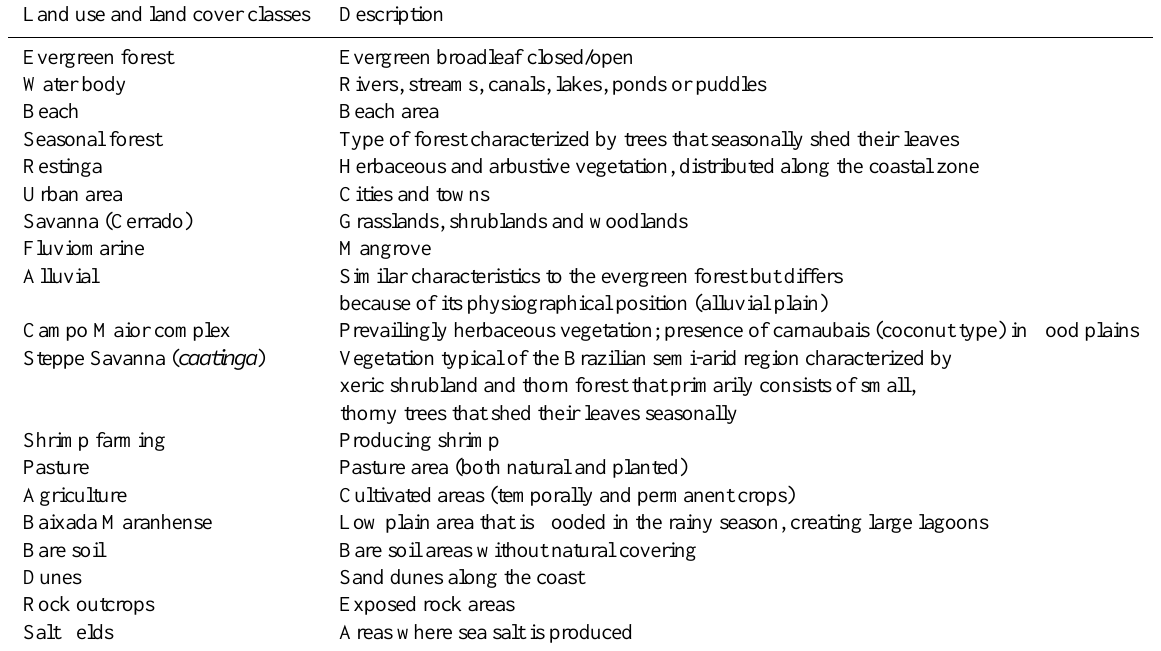
Table 2. Land use and land cover classes. Land use and land cover